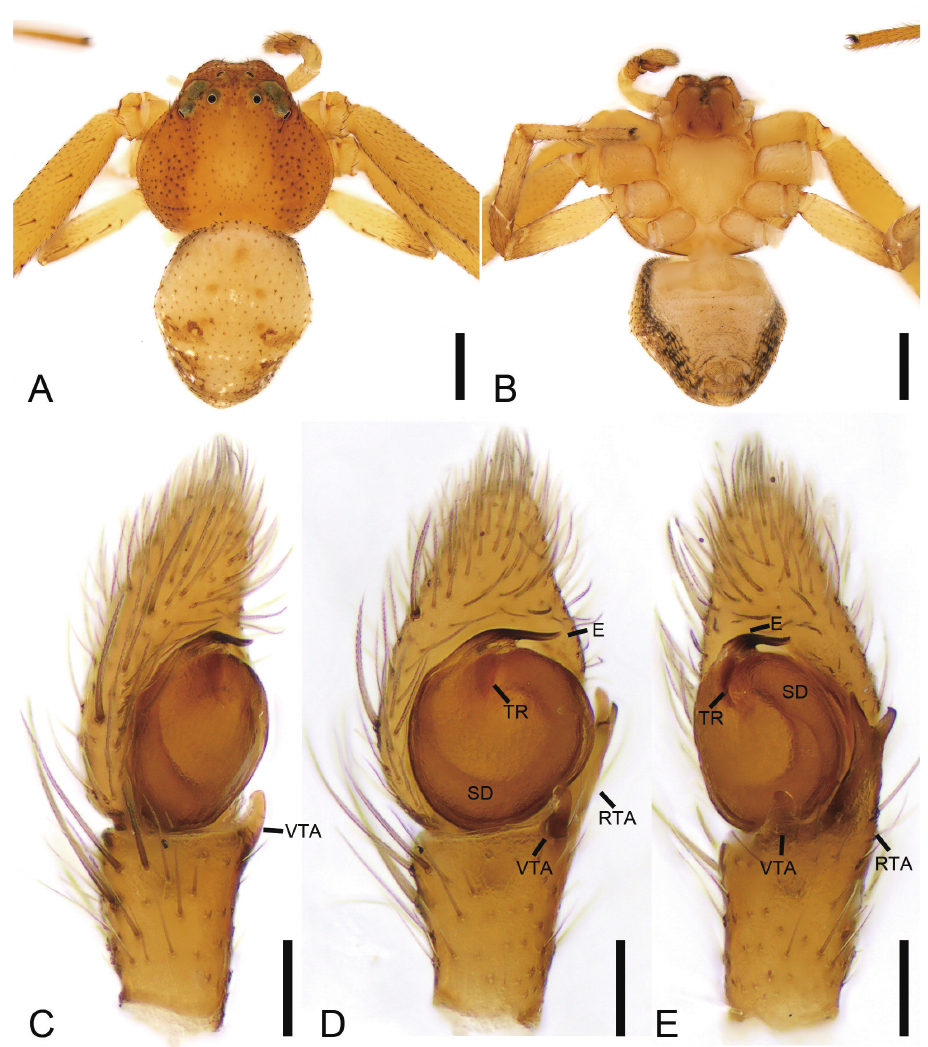
Figure 4. Ebelingia forcipata (Song & Zhu, 1993), male. A habitus, dorsal view B same, ventral view C palp, prolateral view D same, ventral view E same, retrolateral view. Abbreviations: E – embolus, RTA – retrolateral tibial apophysis, SD – sperm duct, TR – tegular ridge, VTA – ventral tibial apophysis. Scale bars: 0.5 mm ( A, B ), 0.1 mm ( C–E